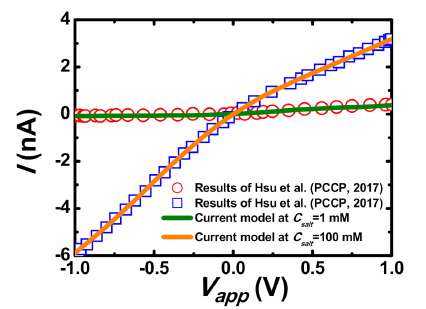
Figure 2. Code validation by comparing the results from the current model (solid curves) with the previous results of Hsu et al. [57], who modeled the current-voltage curves of a polyelectrolyte (PE)-modified nanopore at the two levels of KCl